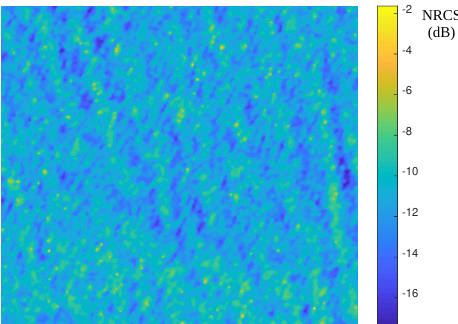
Figure 1. Example of a SAR image towards the Brittany coast taken by the Sentinel-1 plateform on 22 December 2019 with a resolution of 12.5